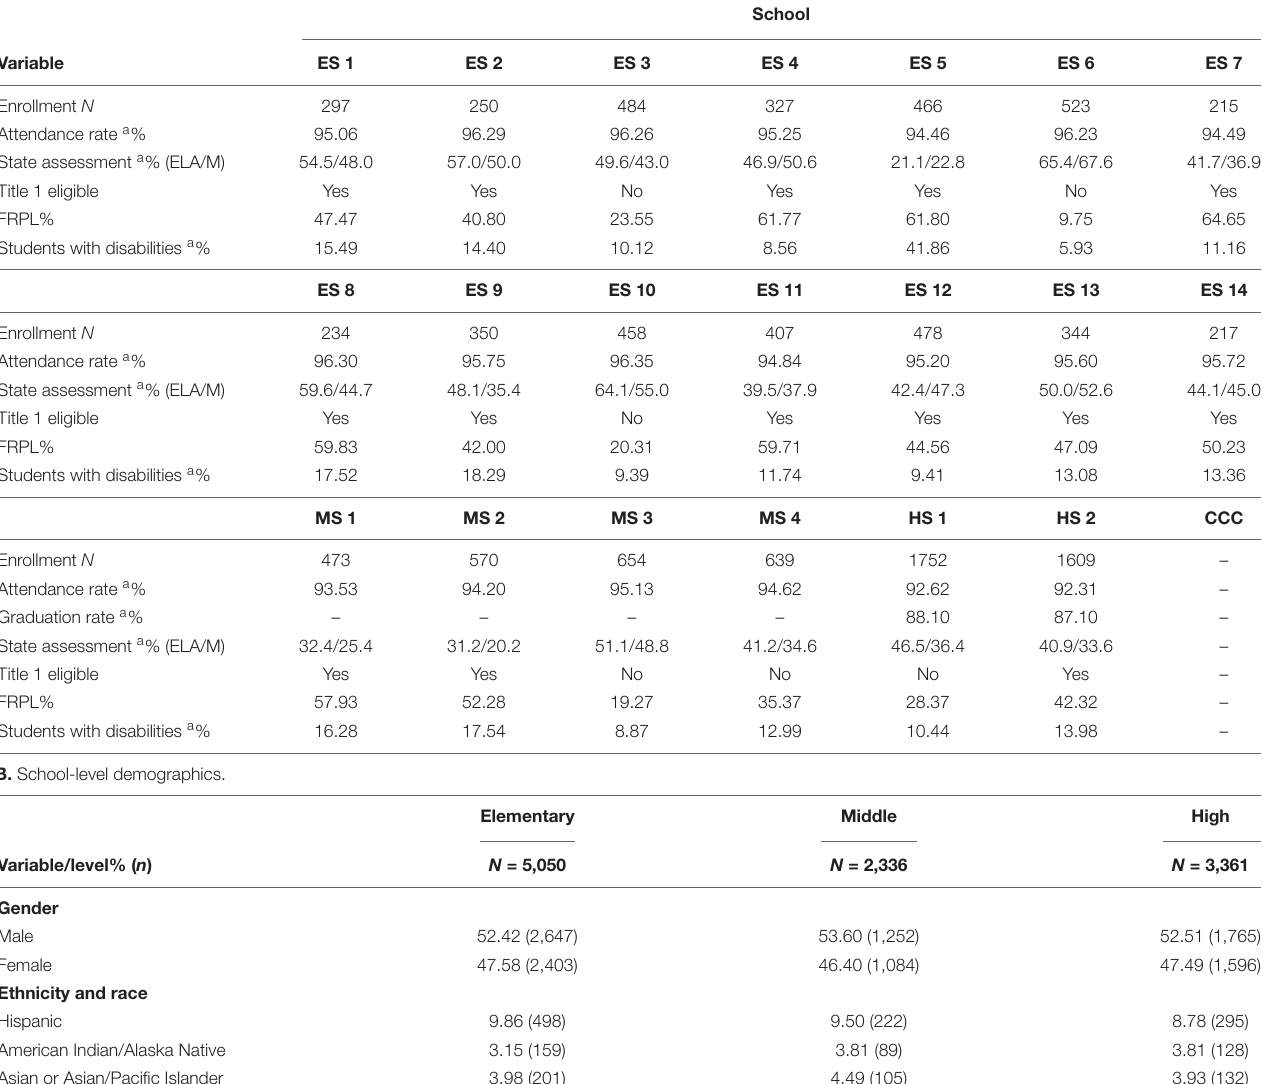
TABLE 1 | A. School